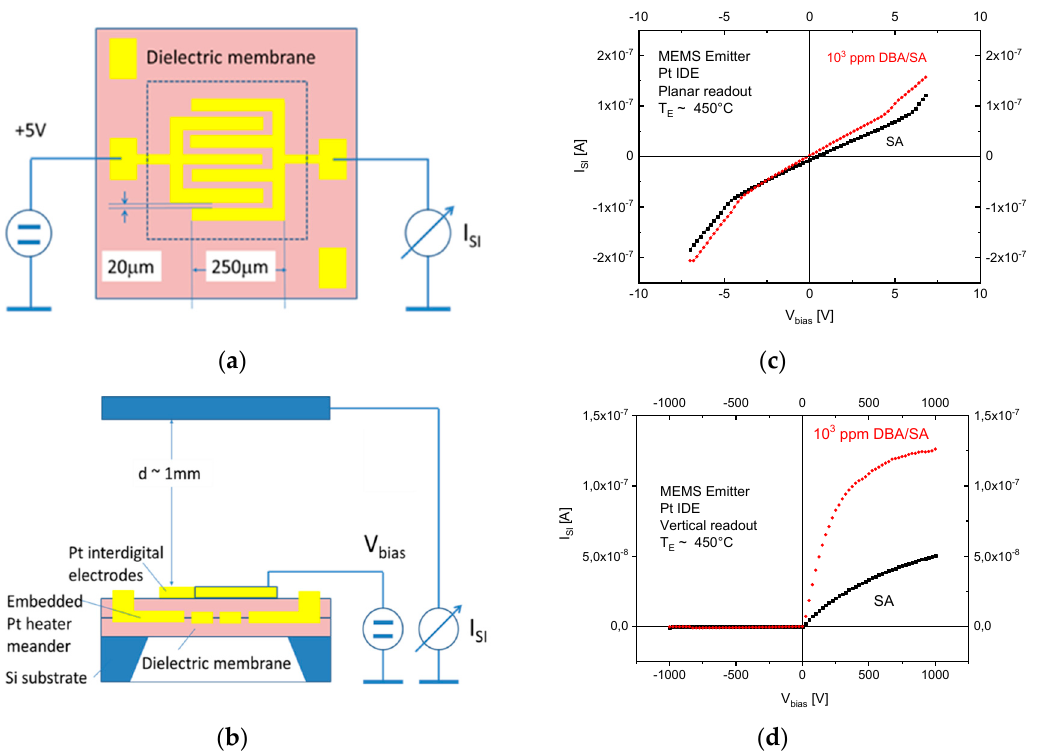
Figure 10. ( a ) Planar and ( b ) vertical readout of SI currents developing at the sharp, lithographically defined edges of the Pt interdigital electrodes of a MEMS microheater chip (Figure 9b). The dotted square in ( a ) denotes the extension of the free-standing membrane area. SI currents as a function of voltages applied across the interdigital Pt electrode gap ( c ), or across the air gap between the microheater and suspended counter electrode ( d ). Reproduced with permission from [12,13].